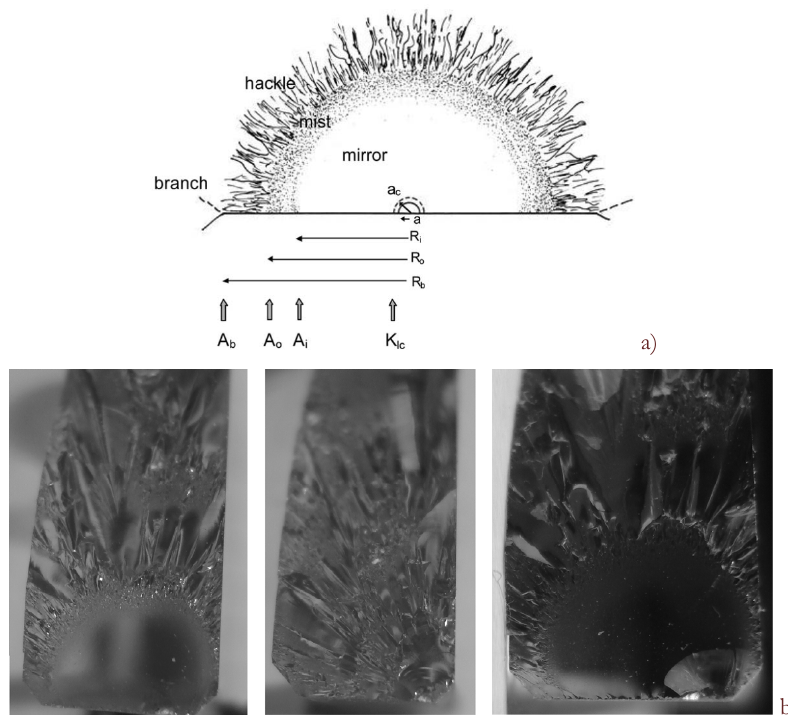
Figure 3: Illustration of the depth flaw and of the mirror